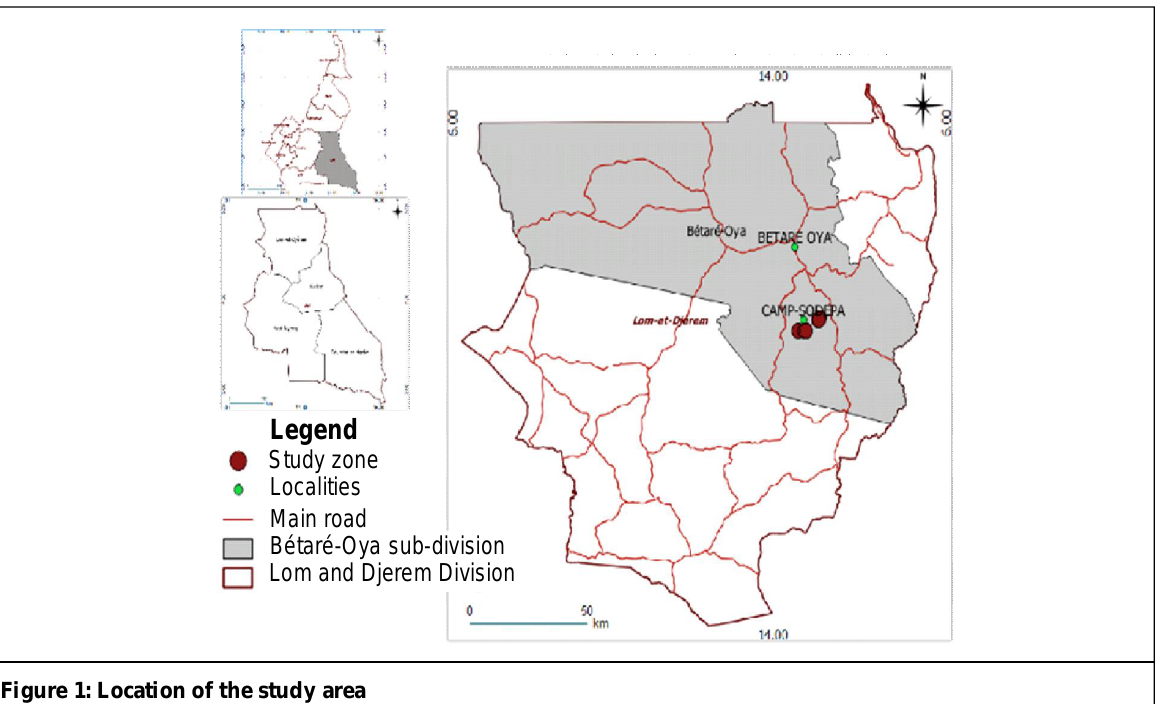
Figure 1: Location of the study area